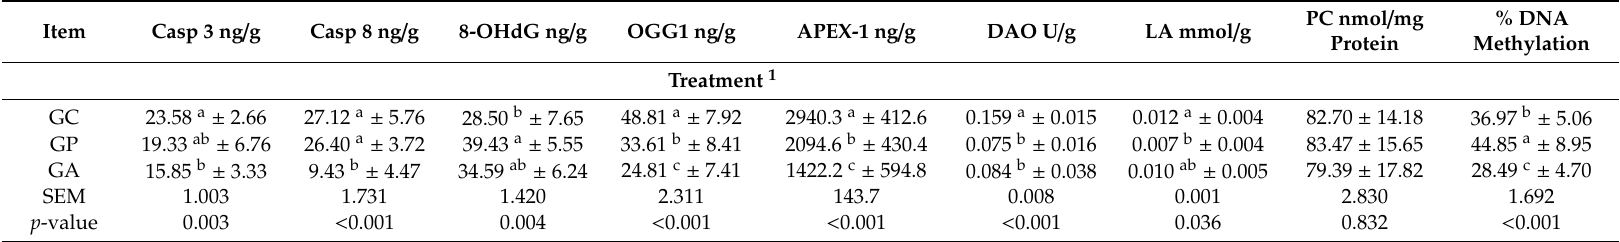
Table 4. Oxidative and epigenetic DNA damage and activity of repair enzymes in intestinal wall of chickens (35 day of